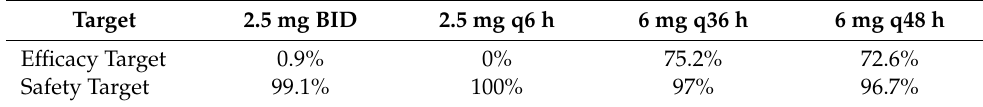
Table 7. Values of the efficacy and safety target for each group of